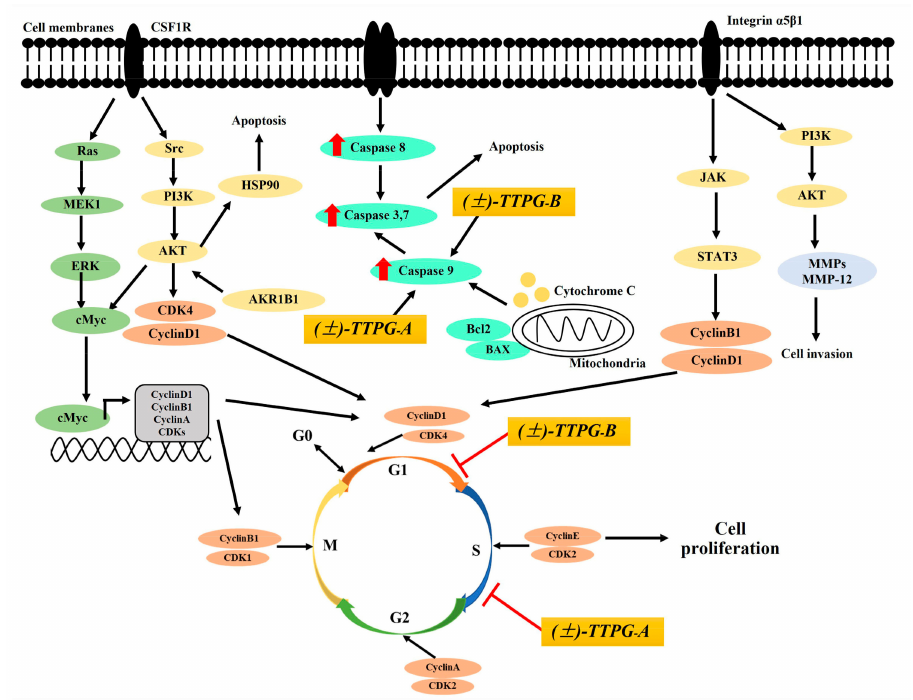
Figure 5. A schematic of the proposed anticancer activity of ( ± )-TTPG-A and ( ± )-TTPG-B on KKU- M213 cells. ( ± )-TTPG-A and ( ± )-TTPG-B increased protein in KKU-M213 cells, which are referred to by the red arrow. The red line represents cells-cycle arrest by ( ± )-TTPG-A and ( ± )-TTPG-B in KKU-M213